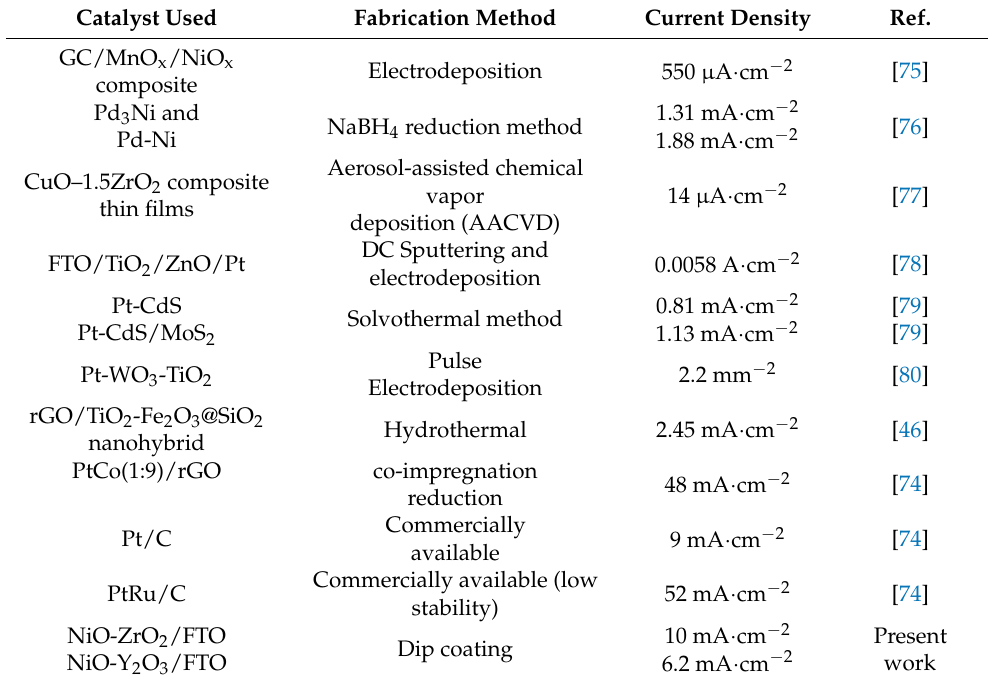
Table 6. Comparison of performance of prepared thin films with